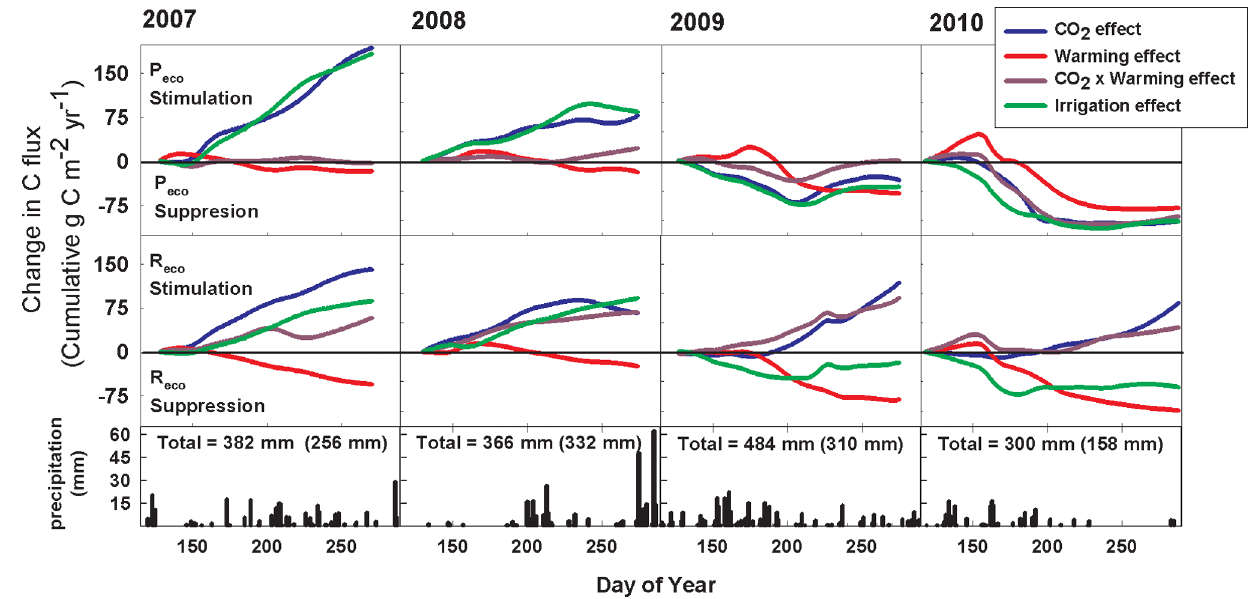
Figure 3. Seasonal patterns of global change effects on C fluxes. Cumulative effects of global changes on gross ecosystem production (P eco ; g m 2 2 yr 2 1 ) and ecosystem respiration (R eco ; g m 2 2 yr 2 1 ) in 2007–2010 at the Prairie Heating and CO 2 Enrichment Experiment (PHACE) in Cheyenne, WY USA. Treatment effects are differences from ambient values for each year of the experiment with increases in fluxes expressed as ‘‘stimulation’’ and decreases in fluxes expressed as ‘‘suppression.’’ Data are expressed as cumulative across the growing season with the CO 2 effect in blue, warming effect in red, CO 2 6 warming interactive effect in purple, and irrigation effect in green. Daily precipitation amounts are depicted in the bottom panel. Both annual and growing season precipitation totals (in parentheses) are included for each year.